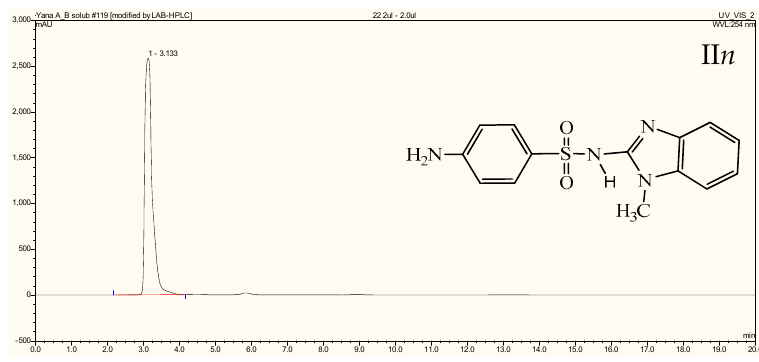
Figure A1. HPLC chromatograms of the synthesized sulfanilamide derivatives IIa – n .